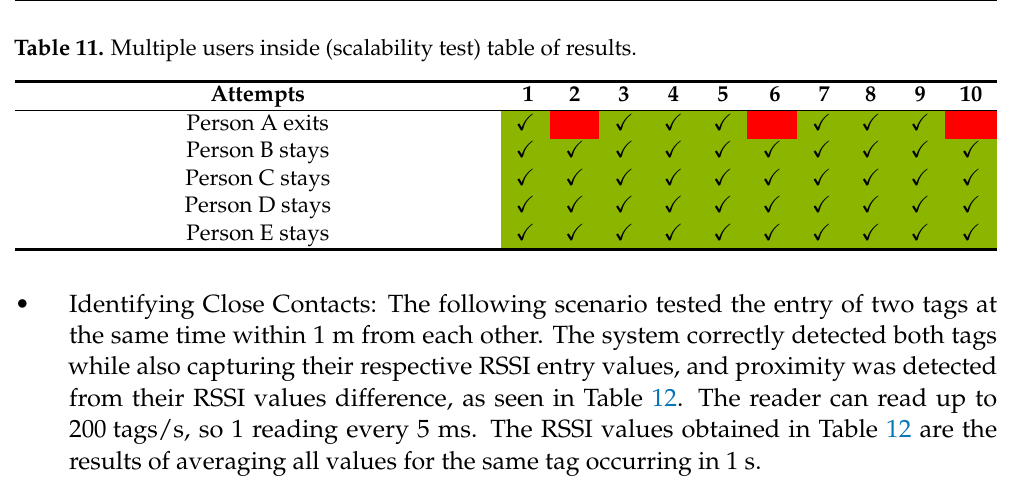
Table 12. Two tags entering simultaneously repeatability